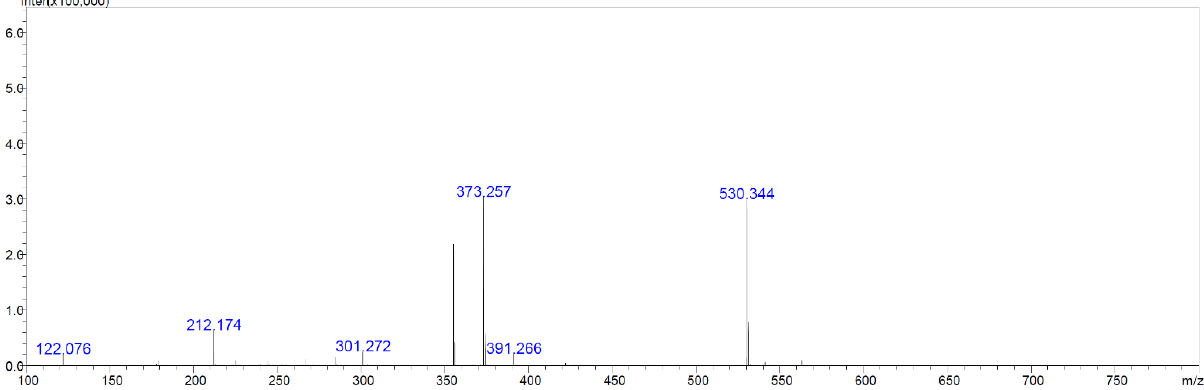
Figure 7. LC-MS chromatogram of the isomer of dichloroanthrabenzoxocinone (M = 529.366 Da).